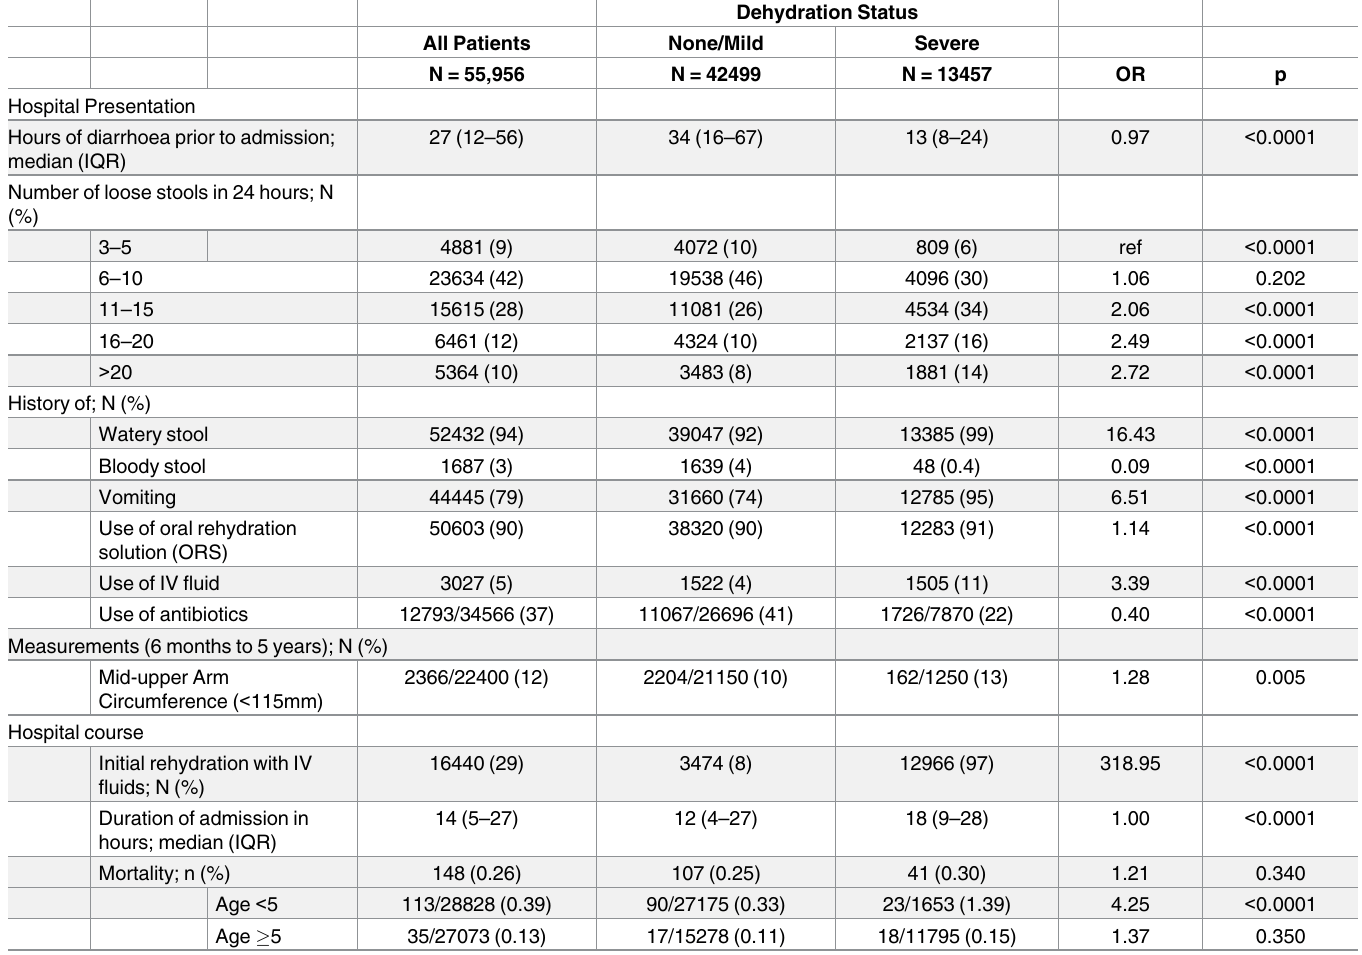
Table 2. Hospital presentation and course in individuals presenting with and without